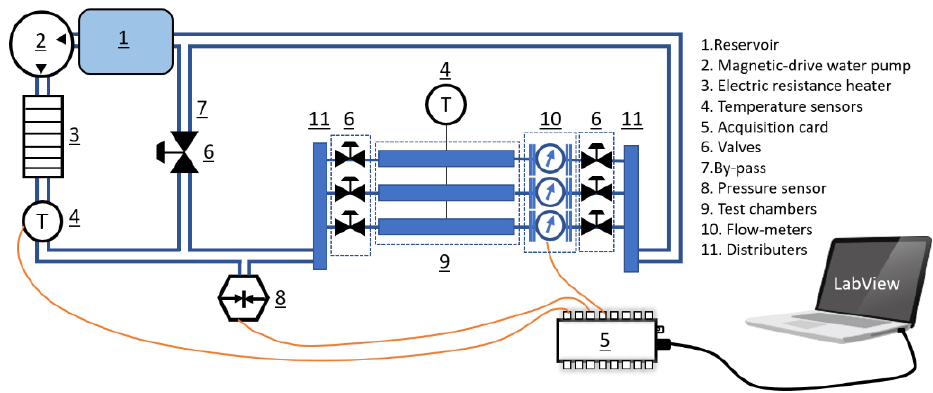
Figure 1. Schematic of the test bench.